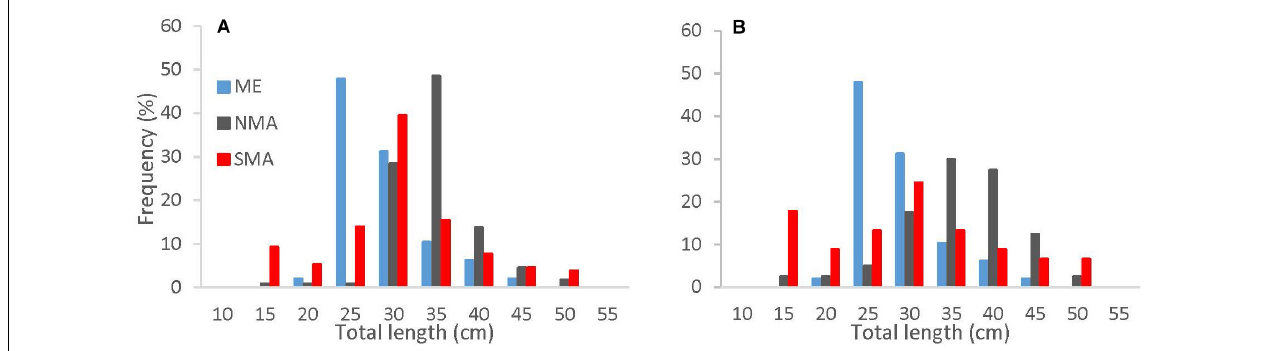
FIGURE 2 | Cumulative length frequency distribution of black sea bass collected in Maine (blue), northern Massachusetts (gray) and southern Massachusetts (red) for (A) all capture methods combined, and (B) trap caught fish